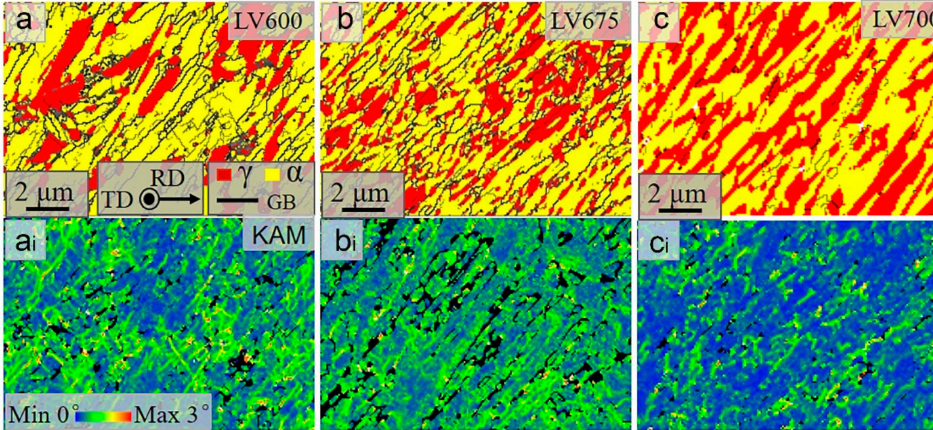
Figure 4. IQ phase maps for LV steel samples ( a – c ) and KAM maps for LV steel samples ( a i – c i ) annealed at different temperatures.